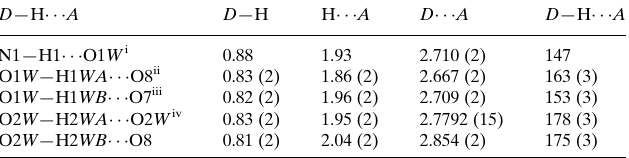
Hydrogen-bond geometry (A˚ , (cid:3)